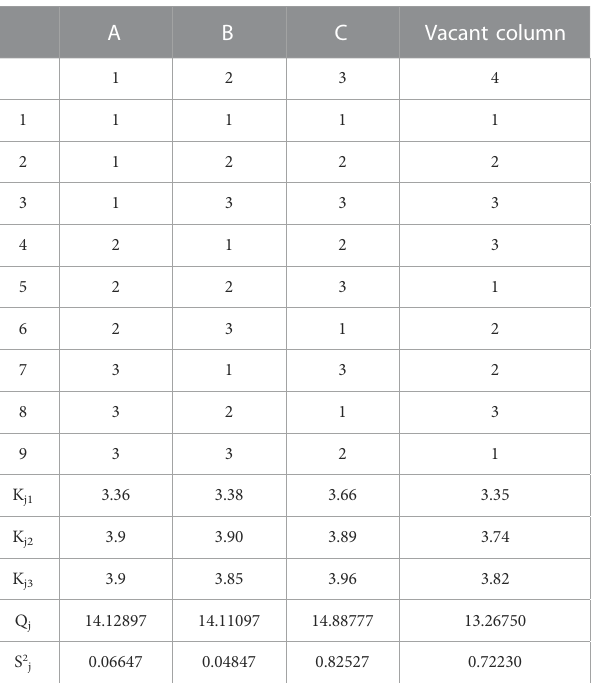
TABLE 8 Calculation